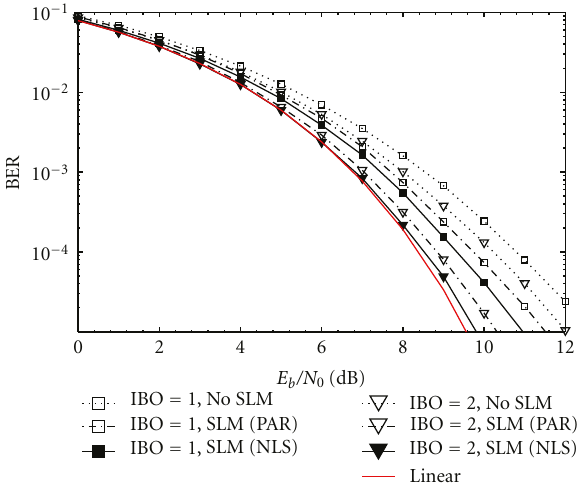
Figure 5: BER of 16-user CDMA signals in presence of PD-HPA.